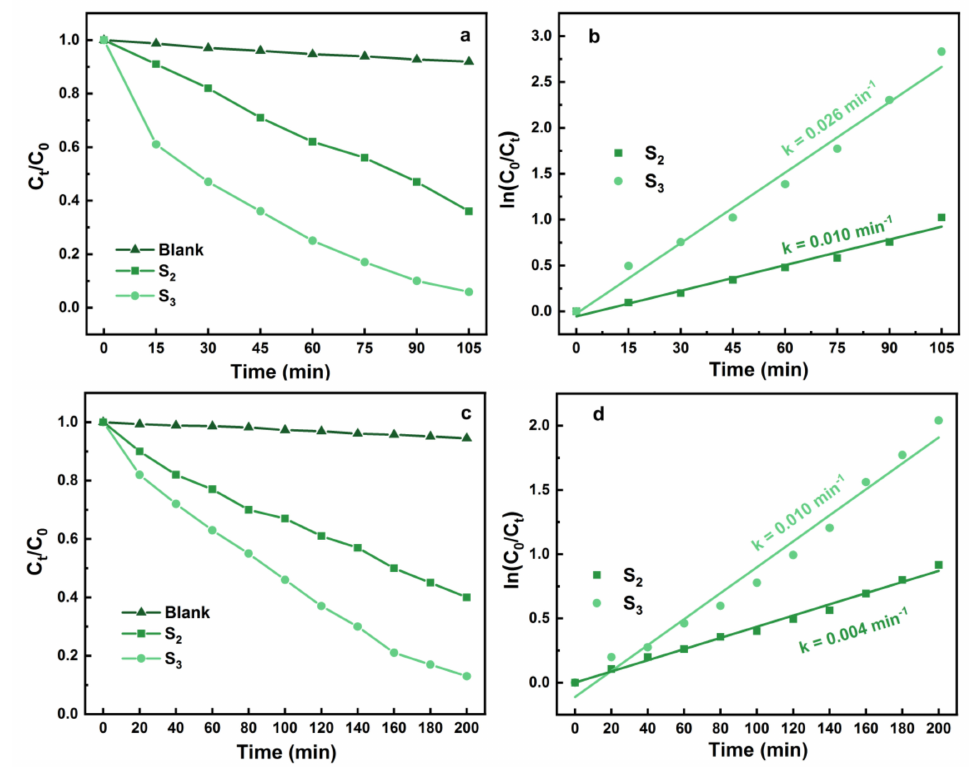
Figure 4. Removal efficiency of ( a ) CIP and ( c ) Cr(VI); the first − order kinetics of ( b ) CIP and ( d ) Cr(VI) by different photocatalysts in single